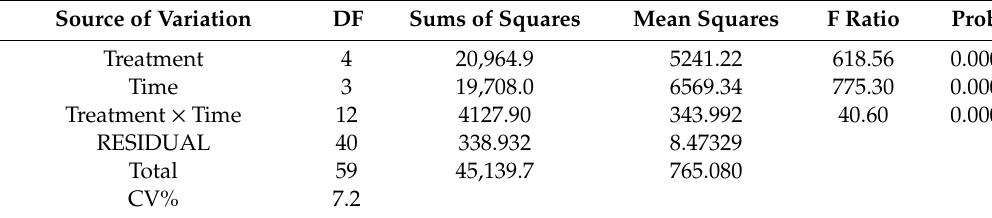
Table 2. Analysis of variance (ANOVA) for the mortality of M. japonica by the binary combinations from four fungal strains of V. lecanii and B. bassiana at di ff erent time intervals.